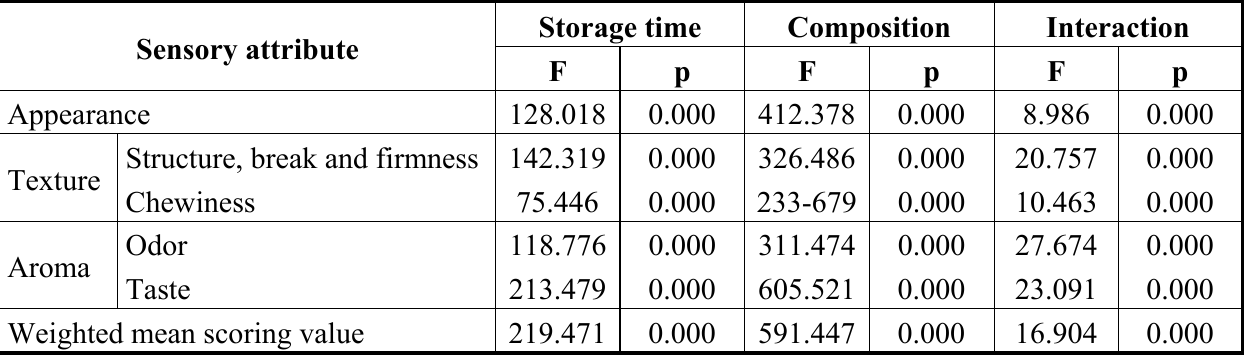
Table 4. Results of two-factorial analysis of variances of dietary